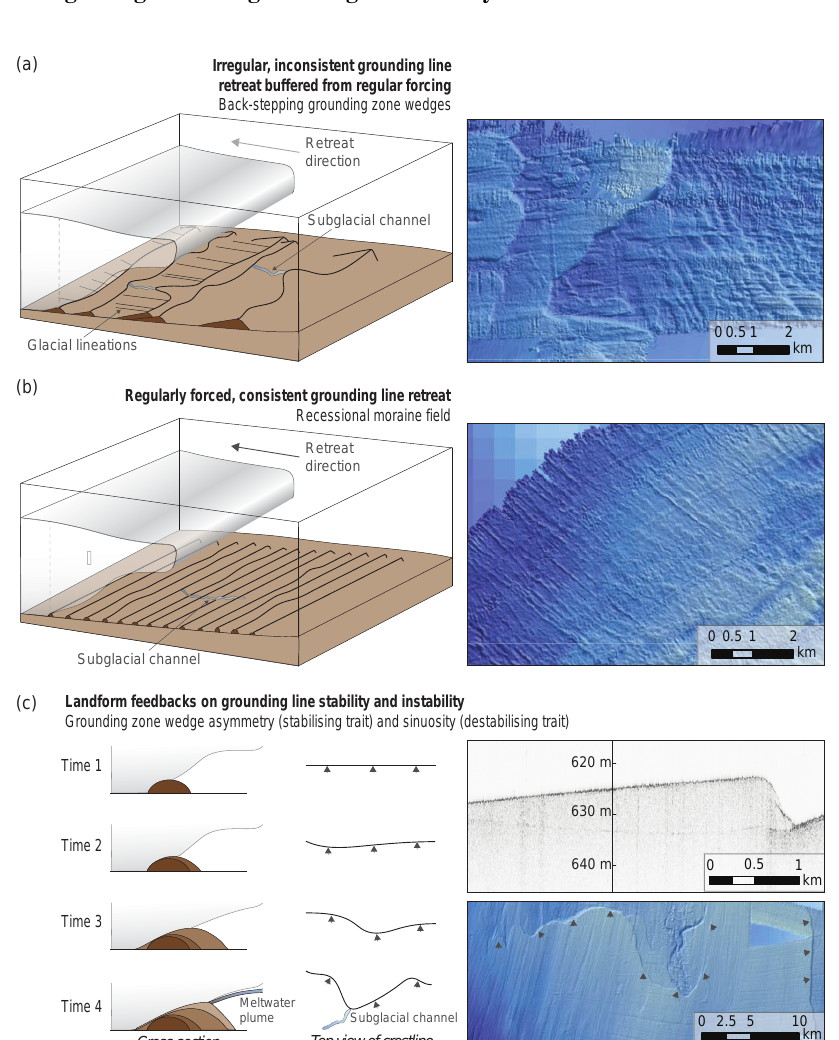
Figure 13. (a) Suite of back-stepping grounding zone wedges with highly variable form and spacing, some with lineated topsets and em- bayments, represent longer durations of grounding position stability while the retreat events are larger and less predictable. (b) Grounding line retreat marked by a series of recessional moraines with consistently small morphologies and relatively close spacing, indicating shorter durations of grounding position stability and smaller, yet higher-frequency, retreat events. Neither does contrasting style of retreat inherently indicate net rate of retreat and, thus, grounding lines forming grounding zone wedges versus moraines do not stipulate relatively fast or slow retreat. (c) Grounding zone wedge asymmetry and sinuosity lead to both stability and instability of grounding lines. With time (and/or increased sediment supply to the grounding line) a symmetric recessional moraine seeds an asymmetric grounding zone wedge that facilitates ice advance (a period of stable grounding). However, as asymmetry is developed, so too is sinuosity (arrows denote grounding zone wedge crest lines), which promotes increased grounding line exposure to ablation processes. Examples of multibeam bathymetry are shown in each panel and an acoustic sub-bottom profile is shown for (c)